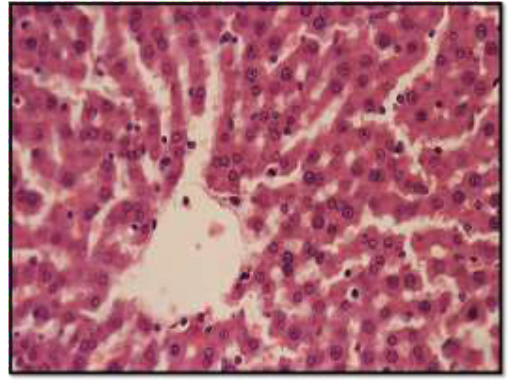
Figure 6b: Photomicrograph of Sudan black stained 5 µm thick frozen section of liver showing Fat droplets (black) in hepatocytes of rat on high-fat diet + Ginseng 200mg/kg (group 4) at ×400.